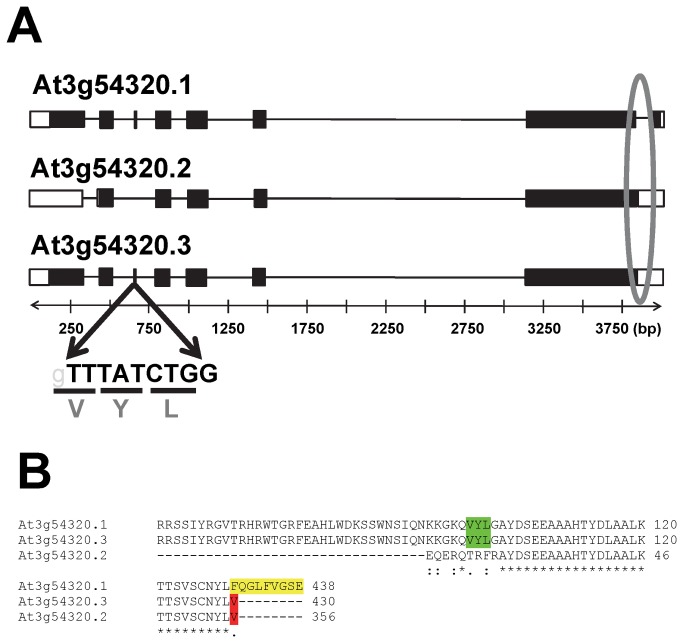
Three predicted alternative splice forms of AtWRI1 (At3g54320.1, At3g54320.2, and At3g54320.3).A) Model of AtWRI1 splice forms 1, 2 and 3. The notable features of these three forms are highlighted: (1) presence in splice forms 1 and 3 of a short 9 bp exon (TTTATCTGG) that encodes amino acids “VYL”; (2) presence of an intron at the 3’ end in splice form 1 and its absence in splice forms 2 and 3 is circled. B) Alignment of predicted protein sequence of three AtWRI1 alternative splice forms. Exon 3 (amino acids sequence “VYL”) in AtWRI1 splice forms 1 and 3 and absence from splice form 2 are highlighted in green. Unique amino acids “FQGLFVGSE” (form 1) and “V” (form 2 and 3) at the C-terminus of AtWRI1 splice forms are highlighted in yellow and red, respectively.